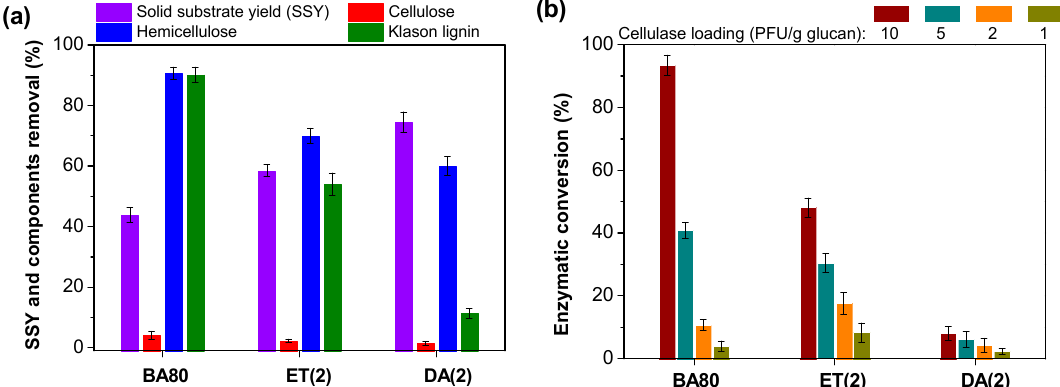
Figure 4. Effects of different pretreatments (DA(2), ET(2), and BA80 pretreatments) conducted at optimized conditions on the ( a ) components removal and ( b ) enzymatic hydrolysis efficiency. All pretreatments were conducted at 80 wt % BA content and 80 °C for 60 min.